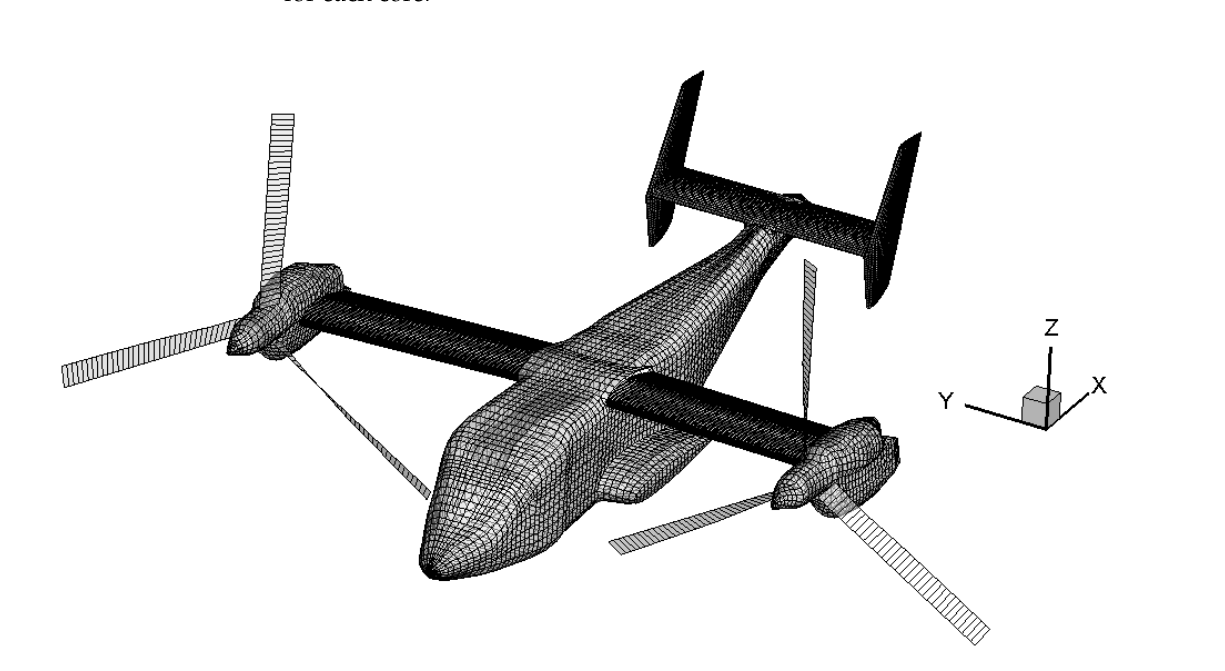
Figure 4. Layout of the numerical model of the full XV-15 tiltrotor.